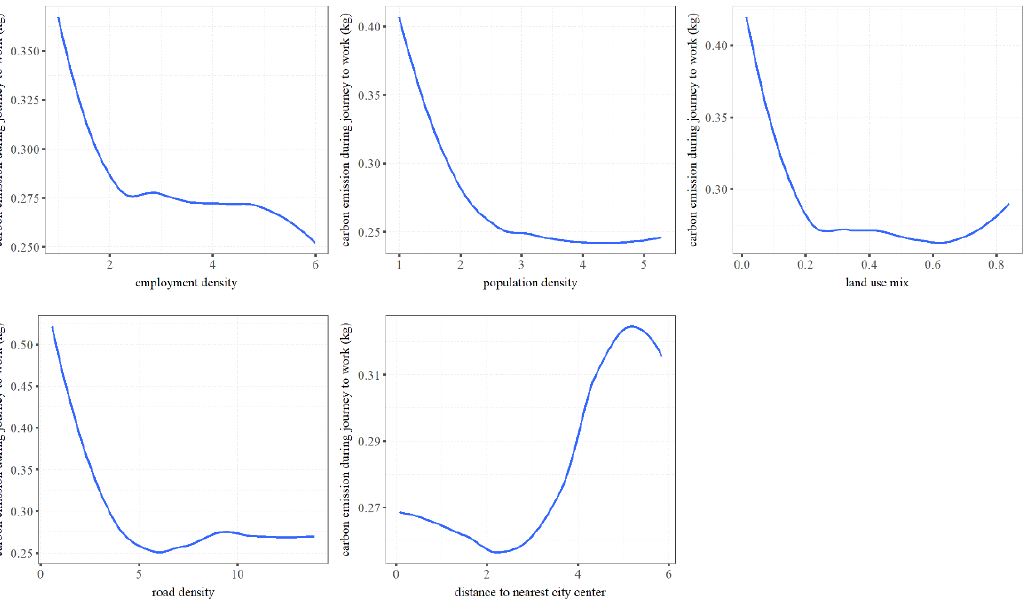
Figure A3. Nonlinear effects of other built environment features on carbon emissions in the central city.